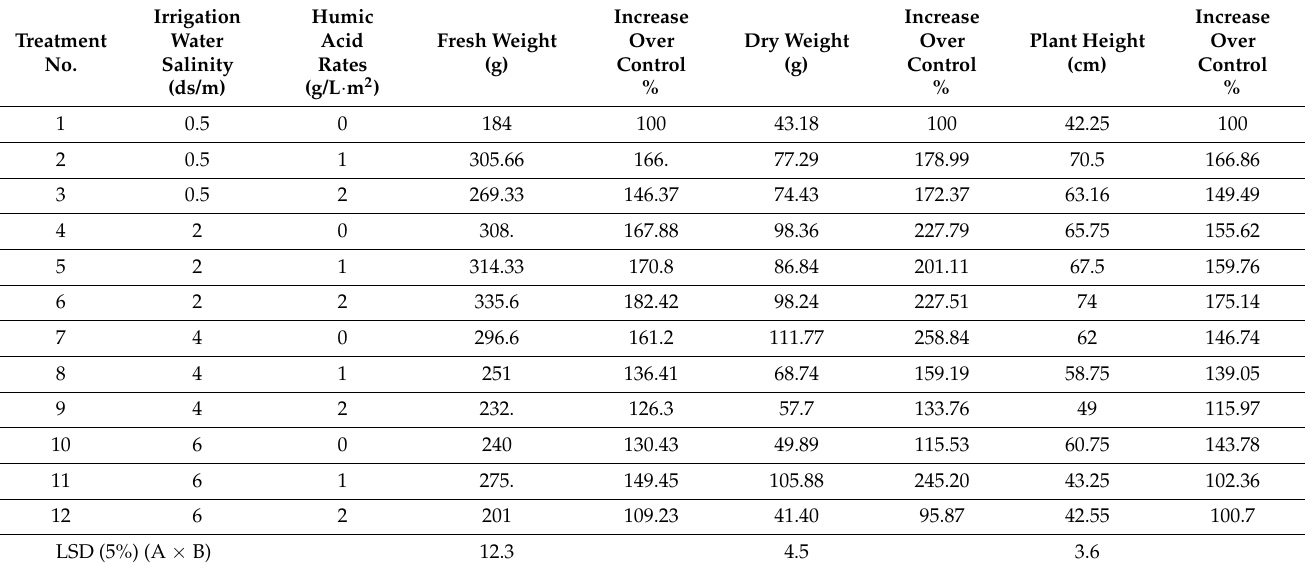
Table 1. Fresh and dry weight and plant height as affected by the application at different